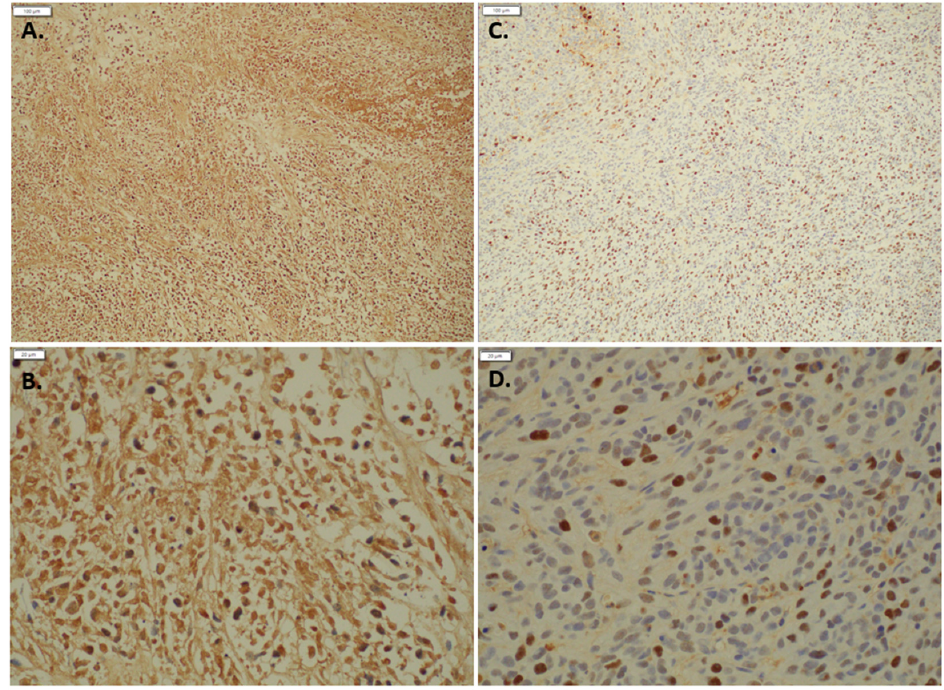
Figure 7. Immunohistochemical staining Retinoblastoma 1 staining with ( A ) Control (10×) ( B ) Con- trol (40×) ( C ) Indolium 1 Treatment (10×) ( D ) Indolium 1 Treatment (40×). Note decreased RB stain- ing in treated tumors ( C , D ).